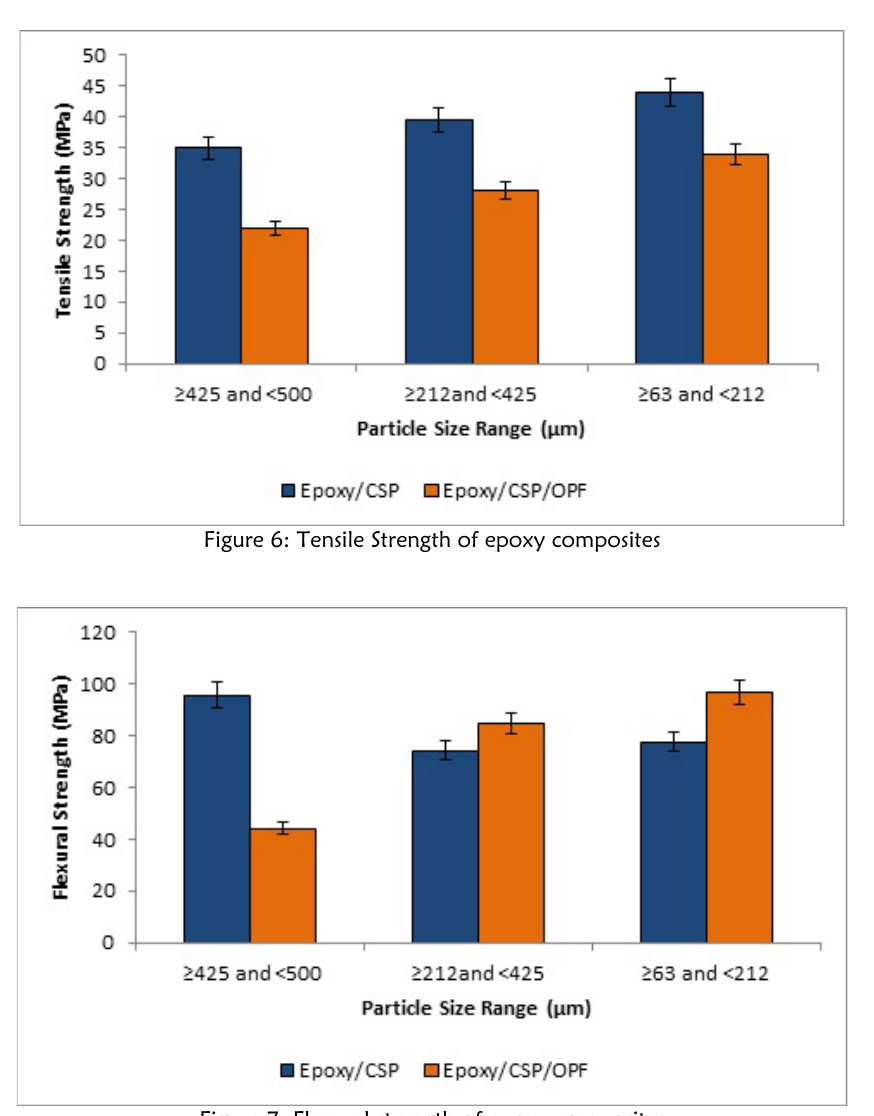
Figure 7: Flexural strength of epoxy composites